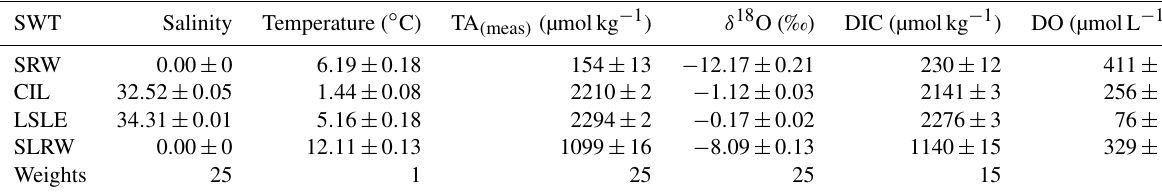
Table 1. Source water type (SWT) definitions for the Saguenay River (SRW), the St. Lawrence Estuary summertime cold intermediate layer (CIL), the Lower St. Lawrence Estuary bottom water (LSLE) and the St. Lawrence River (SLRW). Definitions and variances were derived from data taken in September 2014, May 2016, June 2017 and November 2017. Data for SRW and SLRW were extrapolated to S P = 0. The weights used in the OMP analysis are also shown.